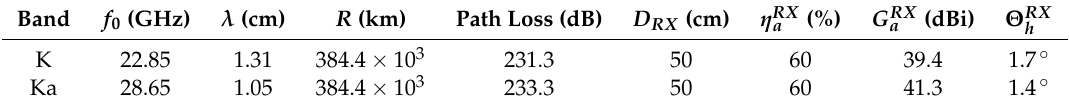
Table 1. Earth-Moon Free-Space Losses in the K/Ka-Bands and Receiver Antenna Gains.